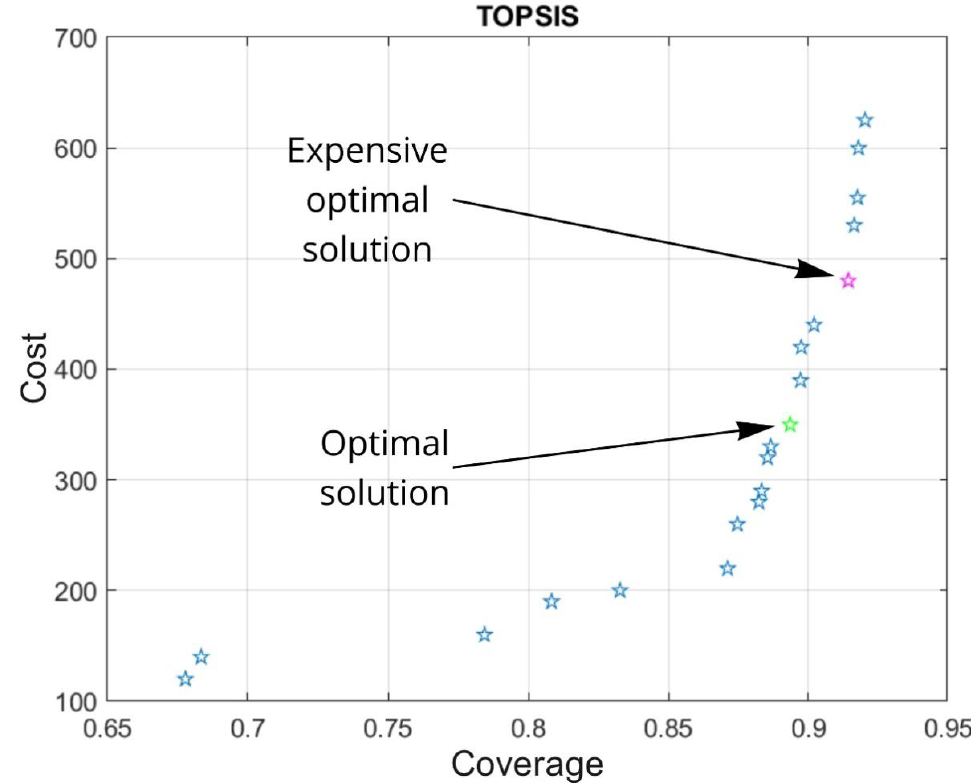
Figure 8. Pareto-front solutions for camera placement. Blue stars — optimal Pareto solutions, green — optimal TOPSIS solution, pink — expensive optimal TOPSIS solution.